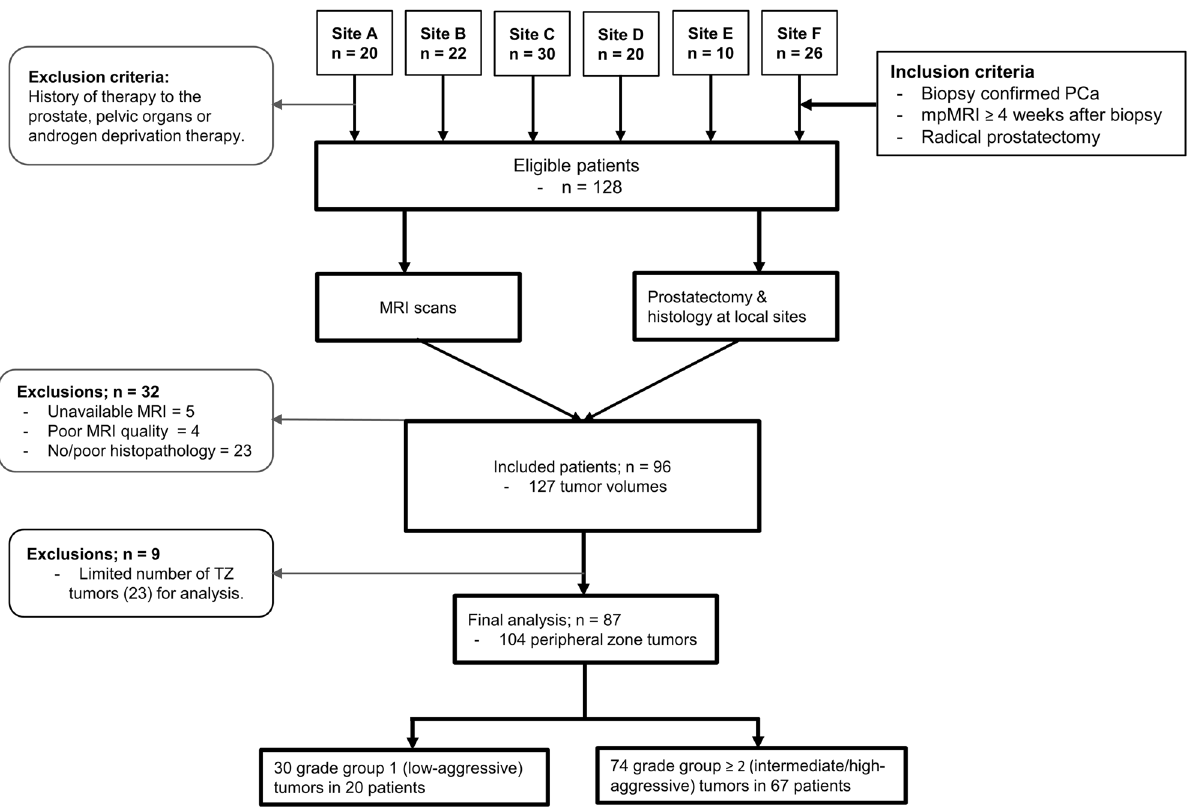
Figure 3. Flow chart of patients and datasets included in study. mpMRI multiparametric MRI, PCa prostate cancer, TZ transition